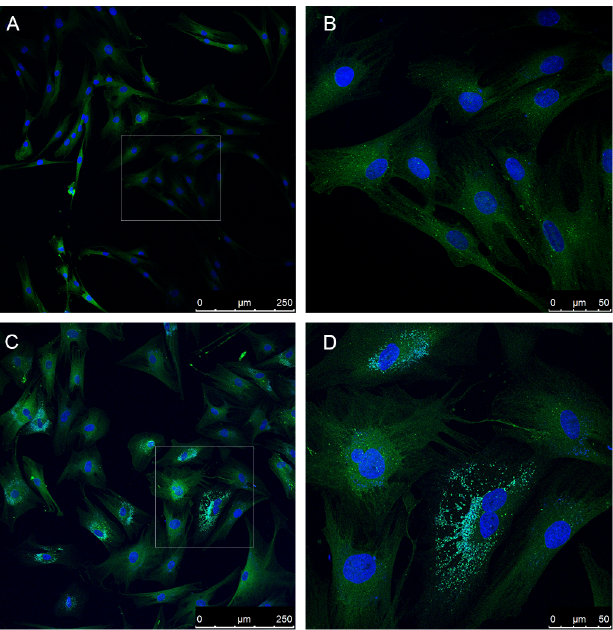
Fig 1. Increased basal levels of autophagy marker LC3 in serially passaged human skin fibroblasts during aging in vitro . Fluorescence confocal photomicrographs of FSF-1 cells stained for LC3 (green fluorescence) and DAPI for nuclear detection (blue fluorescence). Scale bars represent the microscopic magnifications as low or high. (A) Early passage (P14) cells showing the general distribution of LC3 in this population. (B) Selected area from early passage FSF-1 cells at high magnification showing few cells and their internal distribution of LC3 in puncta form. (C) Late passage (P55) near senescent FSF-1 cells, and their overall distribution in the population. (D) Selecgted area from late passage near senescent FSF-1 cells at higher magnification showing distinct senescent morphology, enlarged size and multinucleation, and the extranuclear